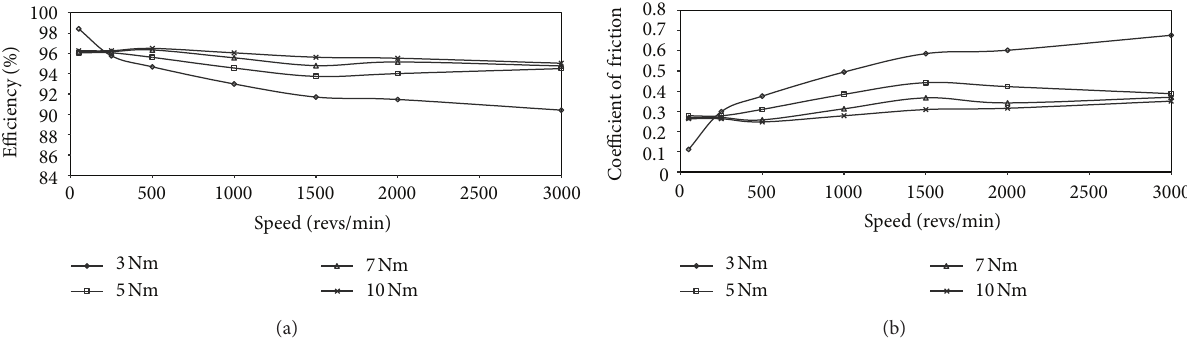
pressure angle PEEK/PEEK gear combinations. ∘